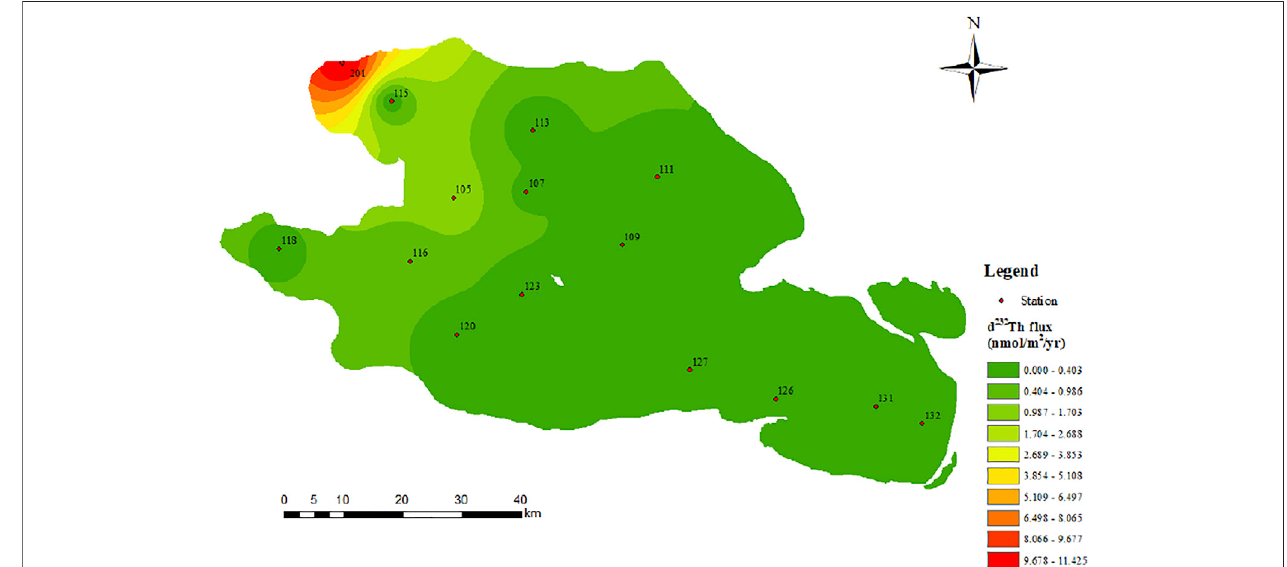
FIGURE 3 | Distribution characteristics of dissolved 232 Th fl ux in the surface water of Qinghai Lake.